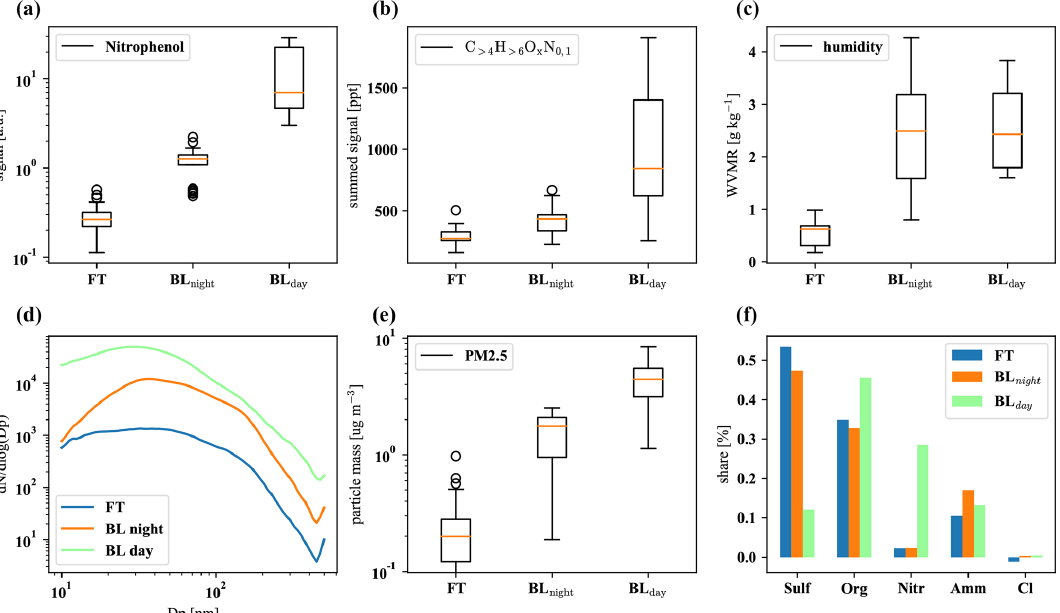
Figure D2. The first row shows nitrophenol (a) , total organics C > 4 H > 6 O x N 0 , 1 (b) , and water vapor mixing ratio (c) ; the second row summarizes particle size distribution (d) , total PM 2 . 5 mass (e) , and composition (f) . The plots are based on 32 data points from averaged 30min intervals each, with nighttime and daytime boundary layer conditions chosen to be as close in time as possible to FT periods with the same prevailing wind direction (horizontal air mass origin) for optimal